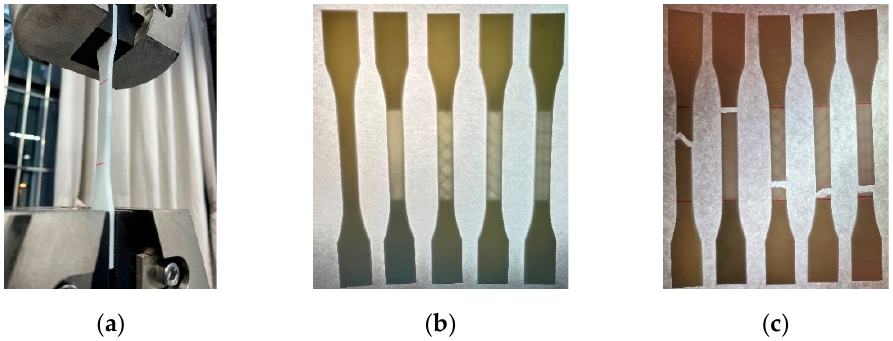
Figure 9. Tensile test of the test sample. ( a ) Tensile test; ( b ) unused sample; ( c ) used